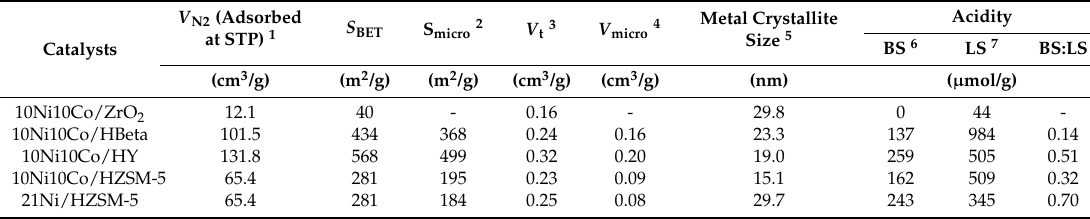
Table 1. Textural and acidic properties of fresh and pre-reduced